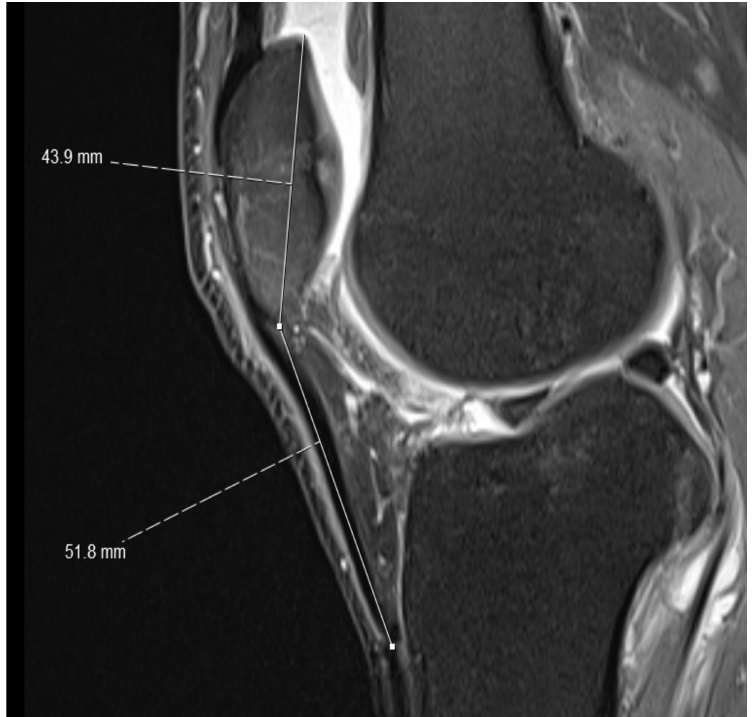
Figure 1. Normal Insall-Salvati index. For the knee in the figure, an Insall Salvati index of 1.18 was obtained by dividing the length of the patellar ligament (51.8 mm) by the patellar pole distance (43.9 mm).